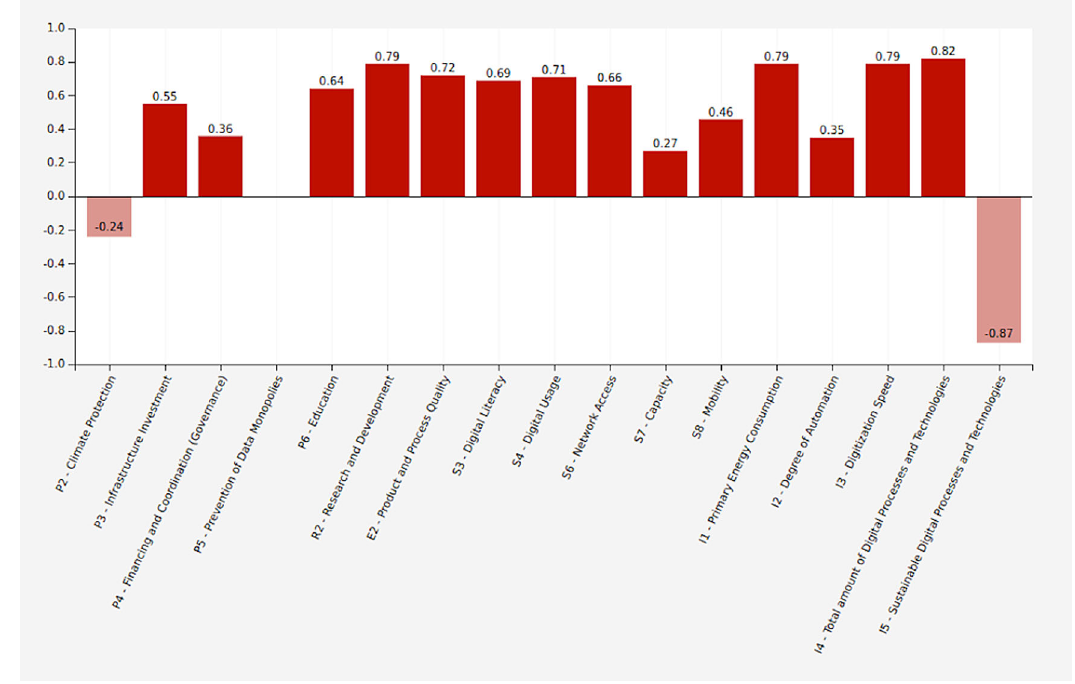
Figure 6. Simulation results. COVID-19 scenario (Screenshot from Mental Modeler